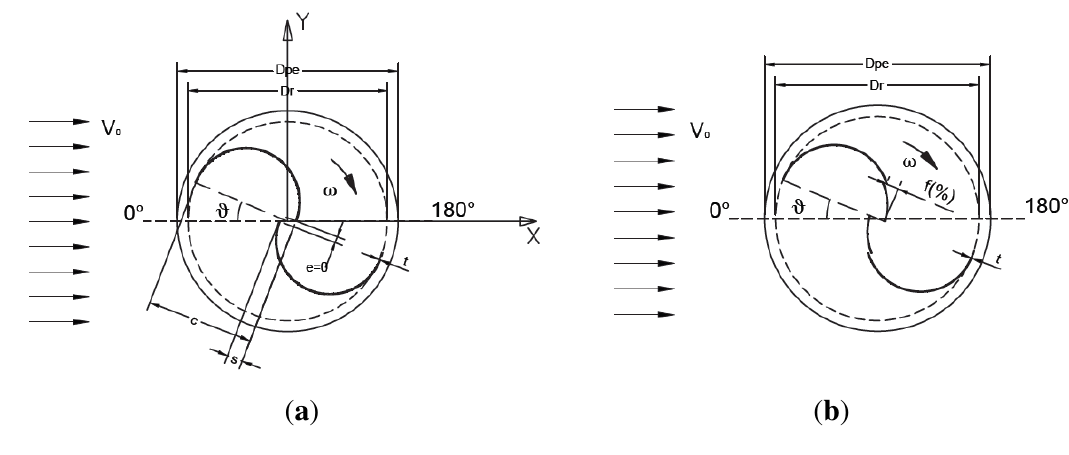
Figure 1. Savonius geometry with buckets ( a ) overlapping; and ( b ) slotted blades.